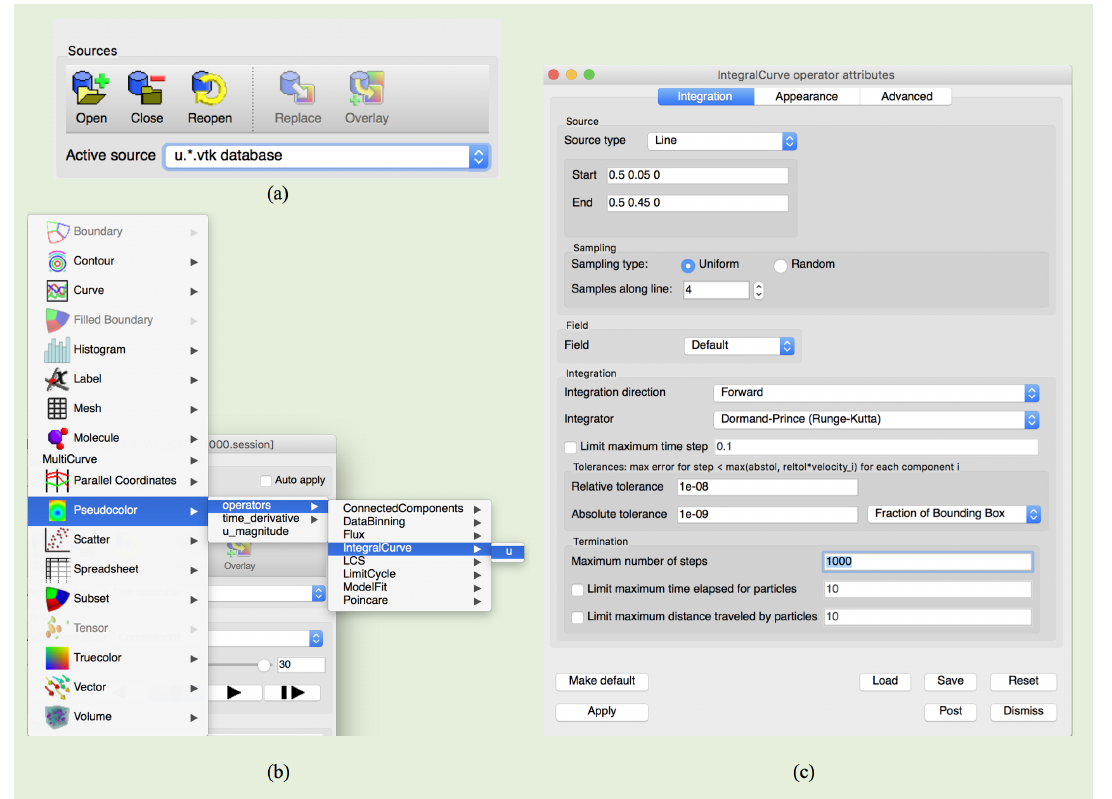
Figure 4. VisIt graphical user interfaces (GUI) interface showing steps to illustrate velocity streamlines, e.g., ( a ) active source must be set on velocity field, ( b ) sequence to plot streamlines, and ( c ) streamline seeding location(s), accuracy tolerances, and solver-type.